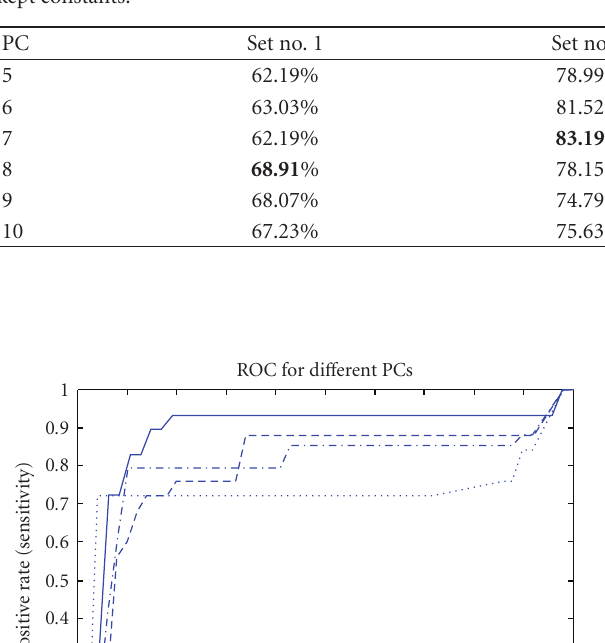
Table 6: The influence of the number of PC on accuracy of the results while learning rate, mapping range, and threshold parameters are kept constants.